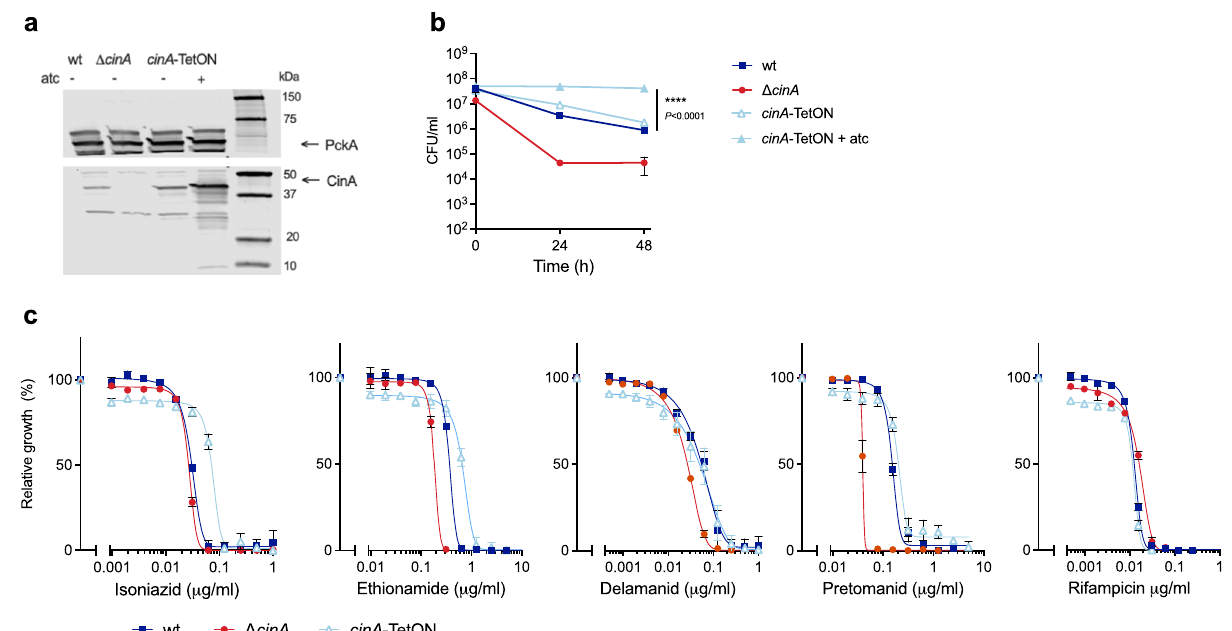
Fig. 4 CinA overexpression increases isoniazid tolerance. a Immunoblot analysis of CinA in wild-type, Δ cinA , and cinA -TetON strains. PckA serves as a loading control. The experiment was performed three times with similar results. b CFU quanti fi cation of the indicated strains after incubation with 0.5 µ g/ ml isoniazid in standard growth media. Data are means ± SD from triplicate cultures and representative of two experiments. Statistical signi fi cance of the difference between wild-type and cinA -TetON + atc was assessed by two-tailed, unpaired t -test, **** P < 0.0001. c Impact of antibiotics on growth of the indicated strains. Data are means ± SD of triplicate cultures and representative of at least two experiments. Source data are provided as a Source Data fi